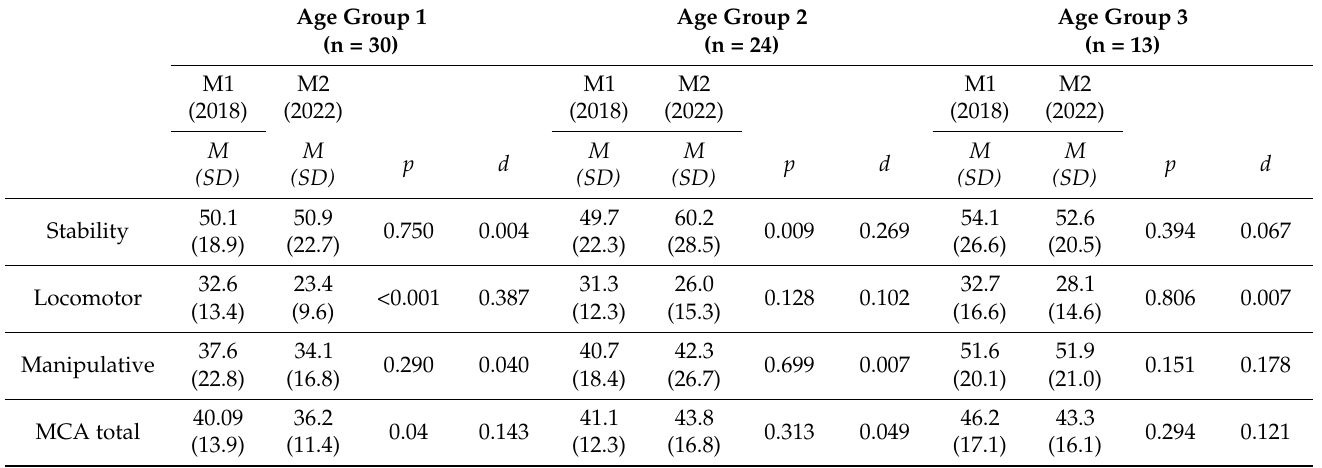
Table 3. MCA percentile values for Subscales and Total scores, by Age Group, and comparison between M1-2018 and M2-2022